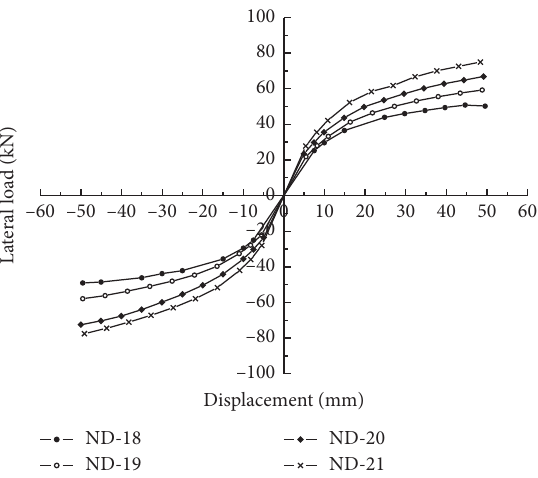
Figure 24: Skeleton curves of slit width